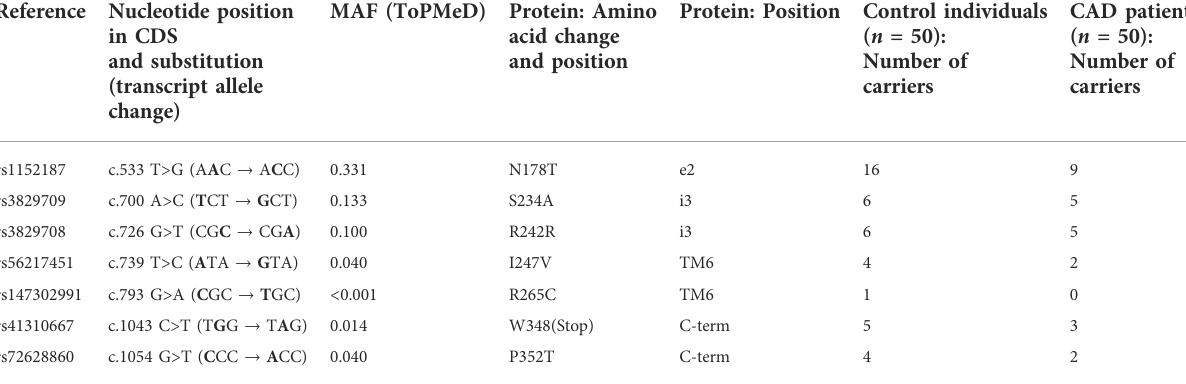
TABLE 2 Identi fi cation of P2RY4 gene variants in control individuals and CAD patients.